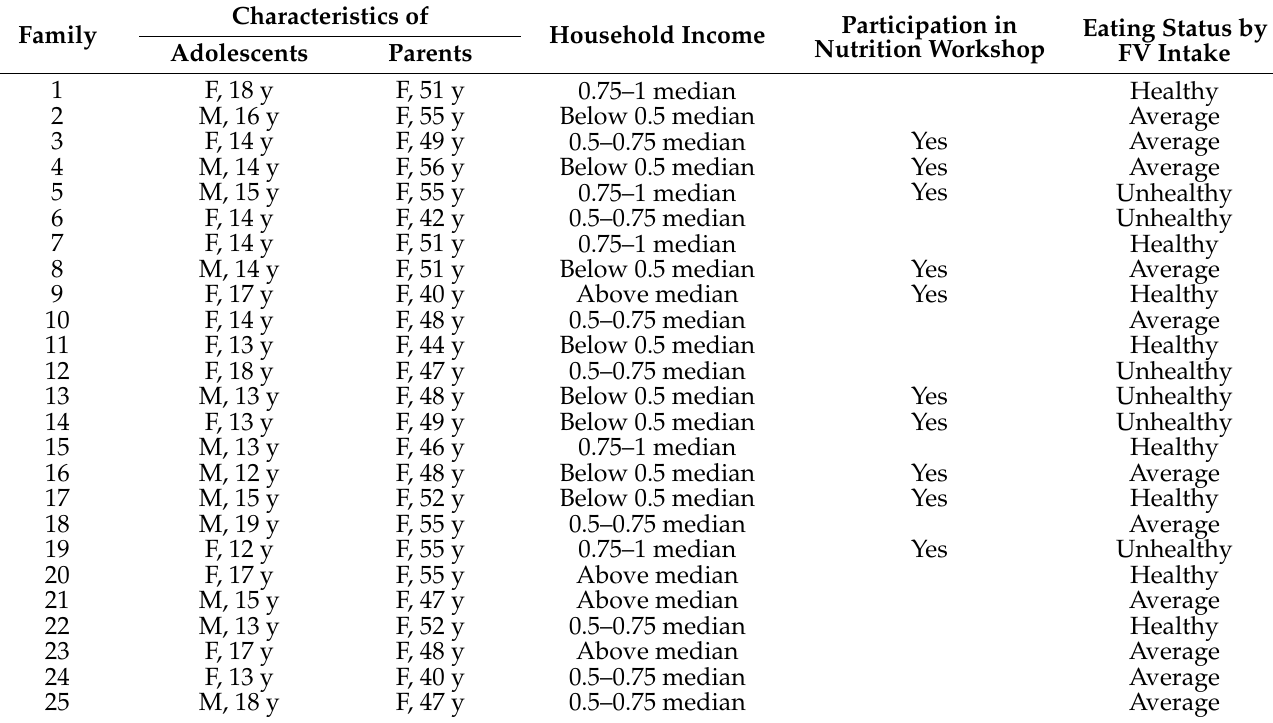
Table 2. Characteristics of parent–adolescent dyads by family.